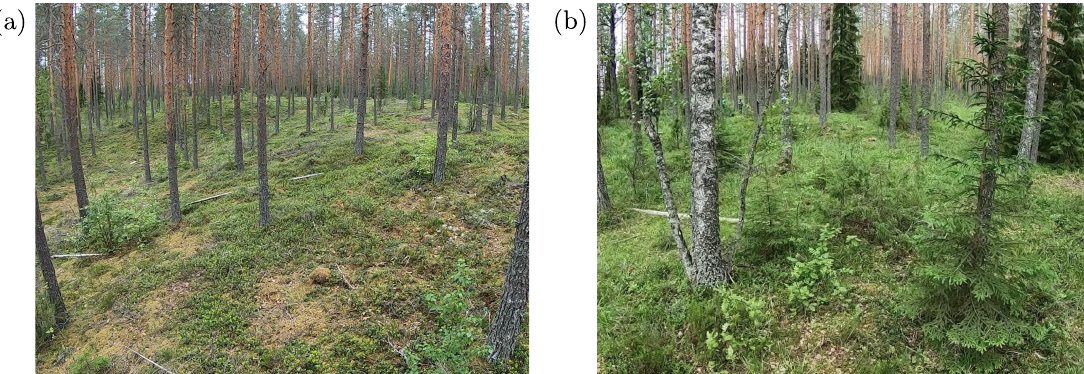
Figure 1. Photographs of ( a ) the sparse plot and ( b ) the obstructed